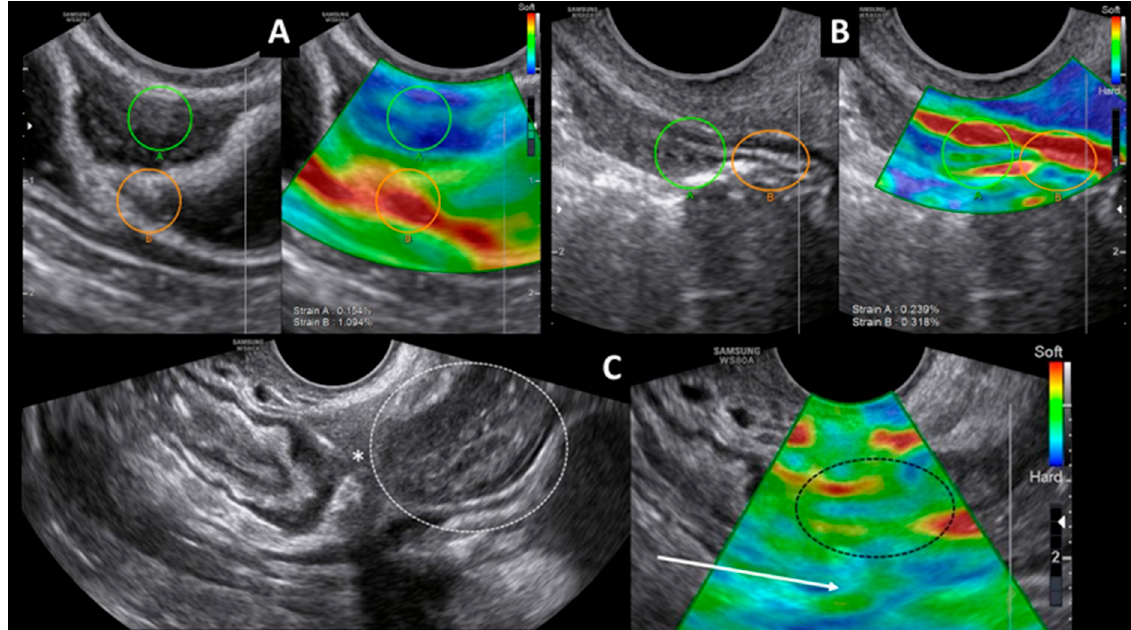
Figure 1. Transvaginal strain elastosonography in different intestinal diseases. Dual-mode greyscale sonographic (left) and strain elastosonography (right) images. ( A ) Deep infiltrating endometriosis on the anterior wall of the rectum. A stiff delineated lesion (blue area) infiltrates through the serosa into the muscularis propria layer. The posterior regular rectal wall is soft (red area). Strain measurement between the lesion in the anterior rectal wall (green circle) and the regular posterior rectal wall (orange circle). The calculated strain ratio (SR) is 7.1. ( B ) Adenocarcinoma on the anterior wall of the rectum. The sonoelastographic appearance of the tumor shows increased stiffness (blue and green area). The serosa of the rectum is uninterrupted (red area). Strain measurement between the tumor (green circle) and the regular rectal wall (or- ange circle). The calculated strain ratio (SR) is 1.33. ( C ) Sagittal transvaginal sonogram in Crohn’s disease. On the greyscale sonographic image (left), thickened intestinal wall (circle) and stricture (asterisk) are visible in the ileocoecal region. The sonoelastographic appearance (right) of the intestinal loops does not show a delineated nodule in the area of the stricture (black circle) but diffuse fibrosis between the adhering intestinal loops (arrow).